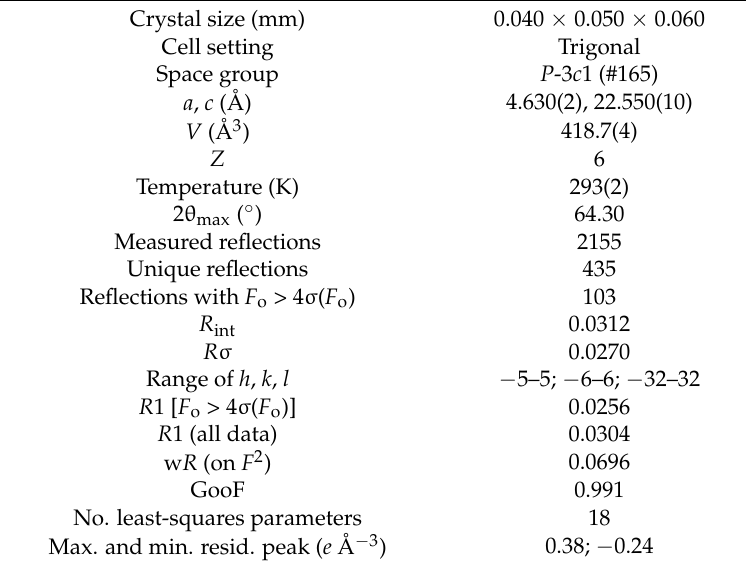
Table 4. Crystal and experimental data for